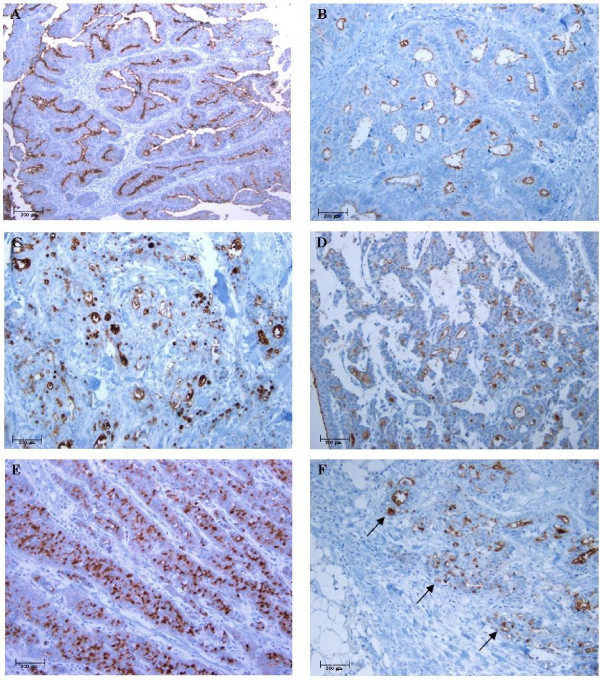
The CD133 IHC expression according to the histologic differentiation of tumors. CD133 is expressed along the glandular luminal side in (A) well-differentiated, (B) moderately differentiated, (C) poorly differentiated tumors, and (D) mucinous adenocarcinomas. Dot-like cytoplasmic staining is observed in poor histologic differentiation (E). CD133 IHC expression is also detected in cancer cells in invasive front (black arrows) (F). (X 100 hematoxylin counterstained).